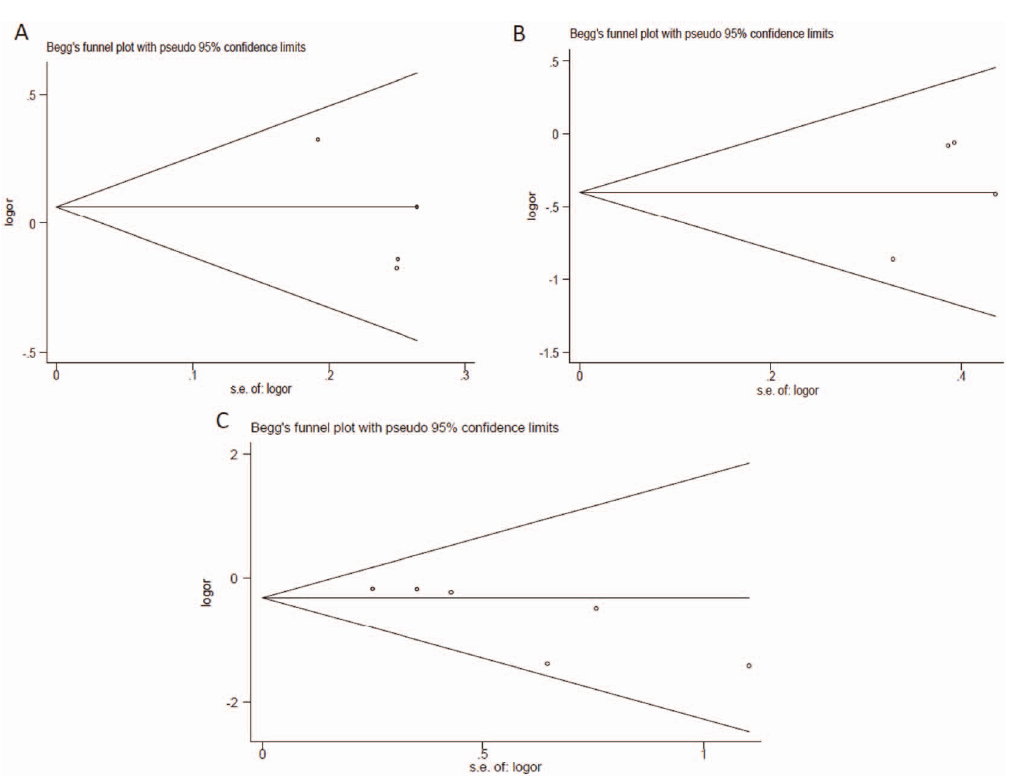
Fig. 4. Begg’s funnel plots for publication bias test for studies in subgroups. A. colorectal cancer group; B. prostate cancer group; C. group with follow- up less than or equal to two